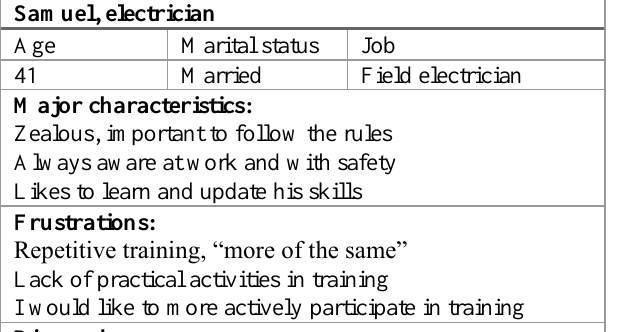
Table 1. Persona to represent electricians.